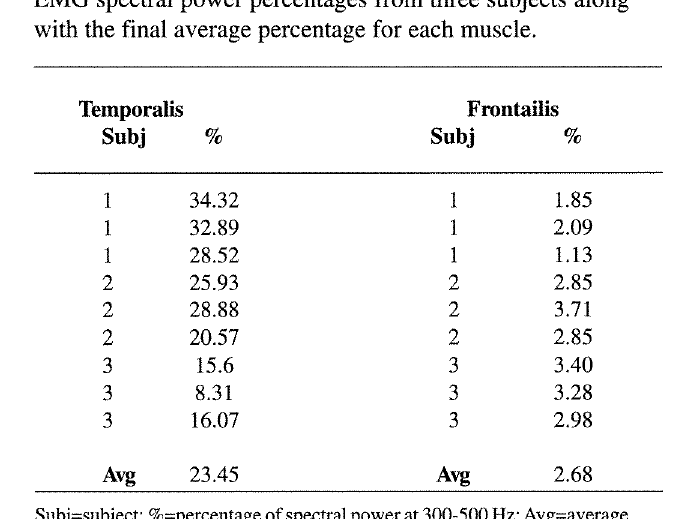
EMG spectral power percentages from three subjects along with the final average percentage for each muscle.